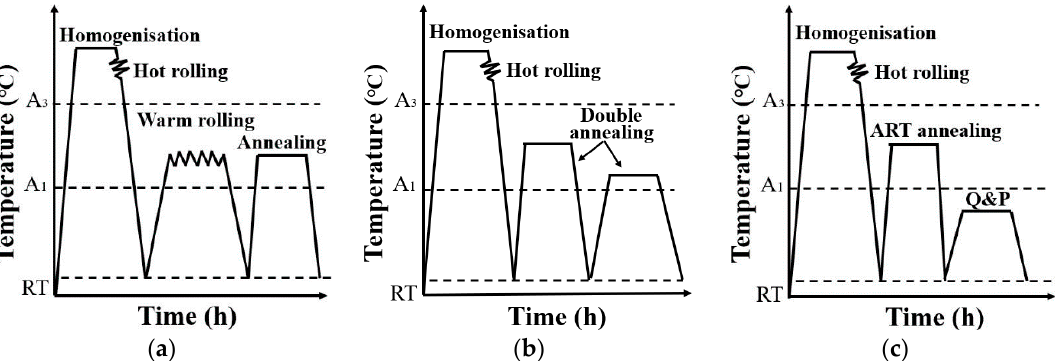
Figure 12. Other novel production processes for MMn steels: ( a ) Warm rolling; ( b ) Double annealing; ( c ) Q&P.